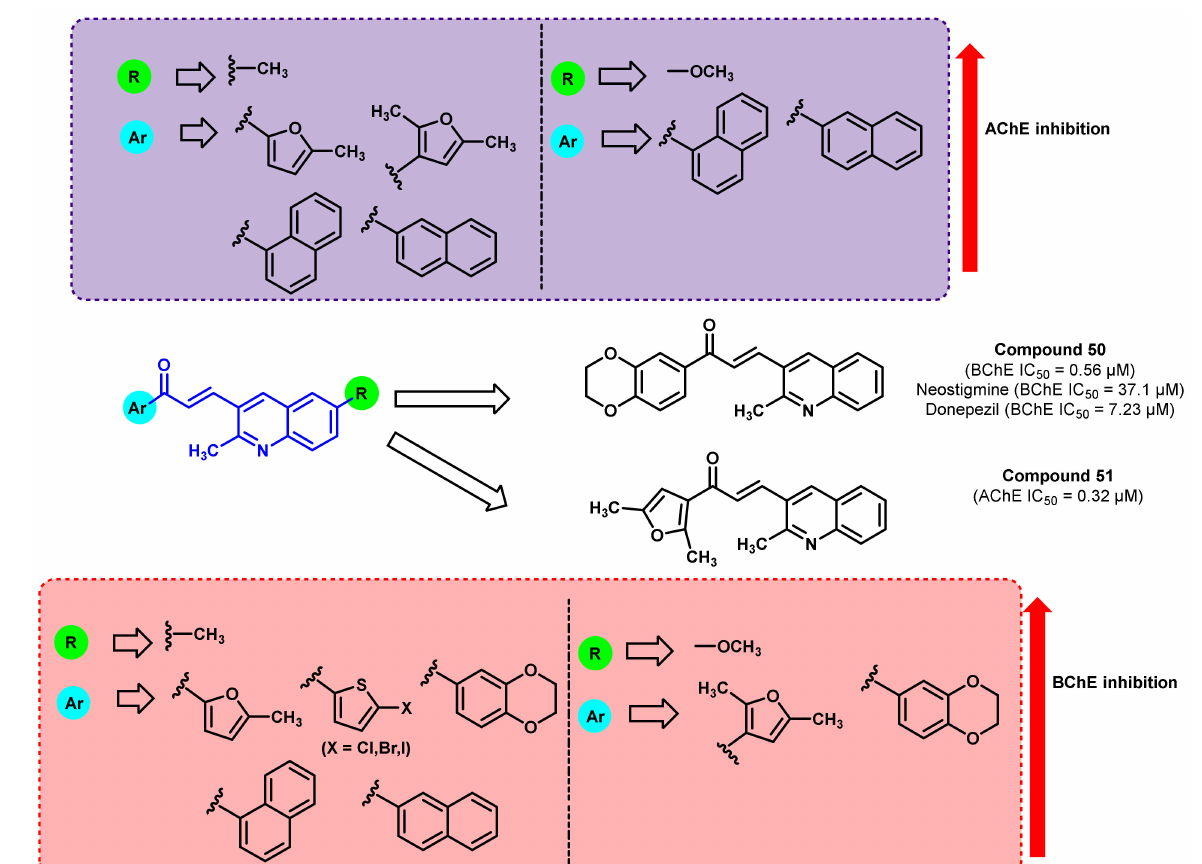
Figure 43. Structural modification of quinolone-substituted chalcone